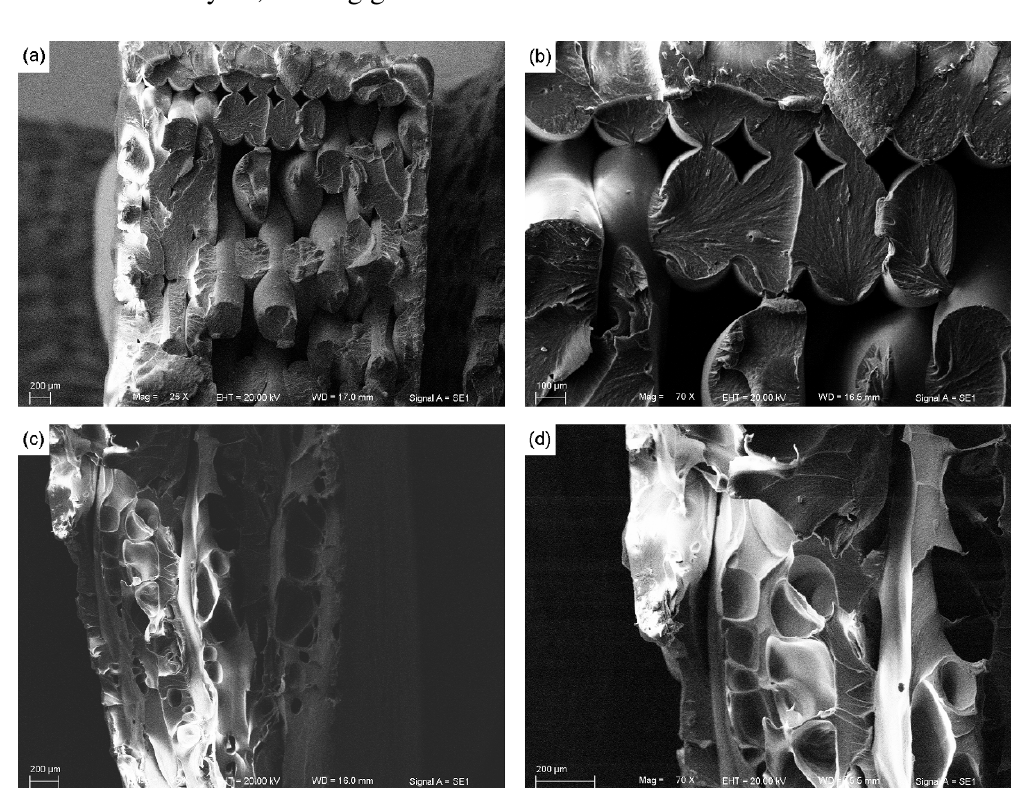
Figure 6. SEM images of fracture cross sections of polyether-ether-ketone (PEEK) and acrylonitrile butadiene styrene (ABS). ( a ) ABS, 25×; ( b ) ABS, 70×; ( c ) PEEK, 25×; ( d ) PEEK,